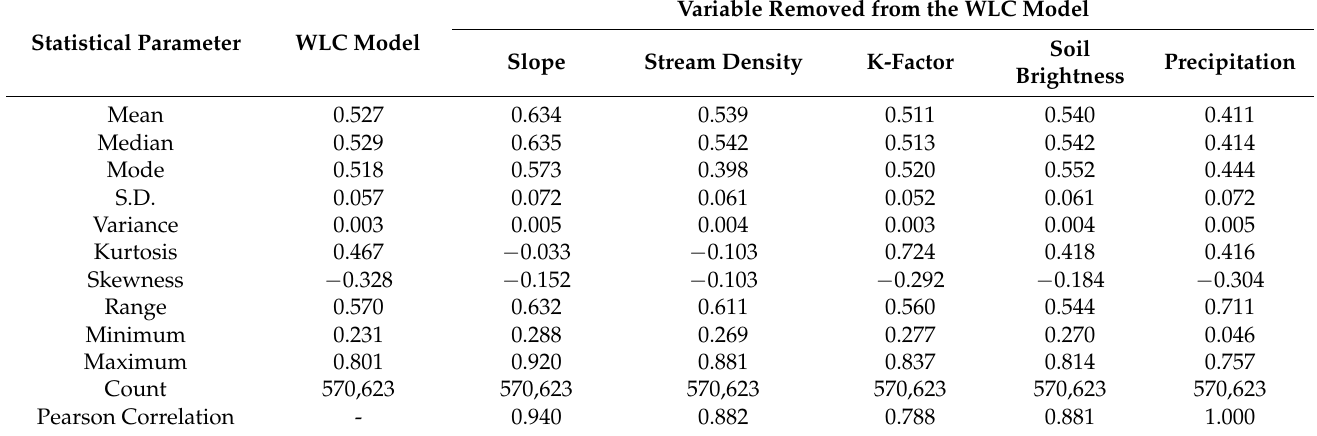
Table 3. Descriptive statistics and Pearson correlation for sensitivity